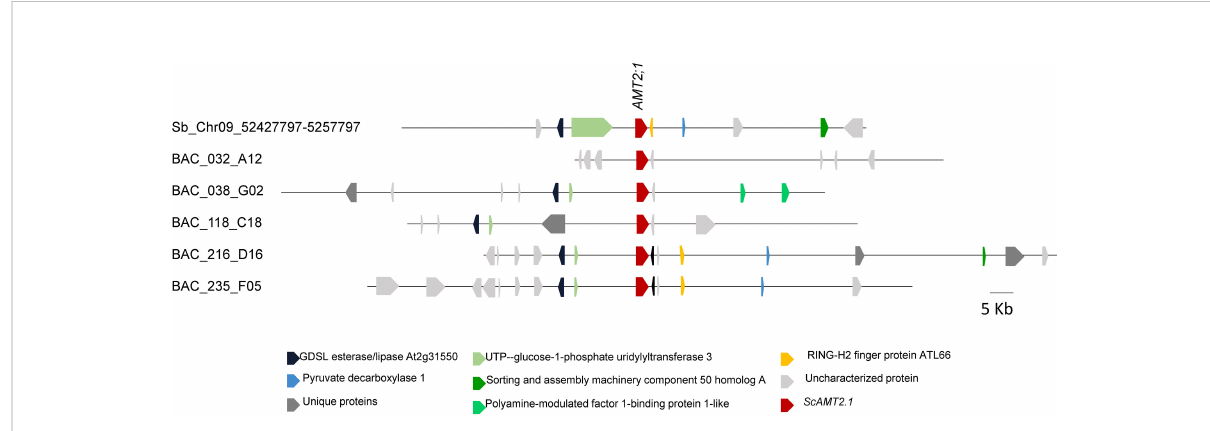
FIGURE 1 Physical map of genomic sequences (100 Kb) containing AMT2;1 from sugarcane ( Saccharum spp. ‘ R570 ’ ) BAC clones (032_A12, 038_G02, 118_C18, 216_D16, and 235_F05) and S. bicolor (chromosome 9;